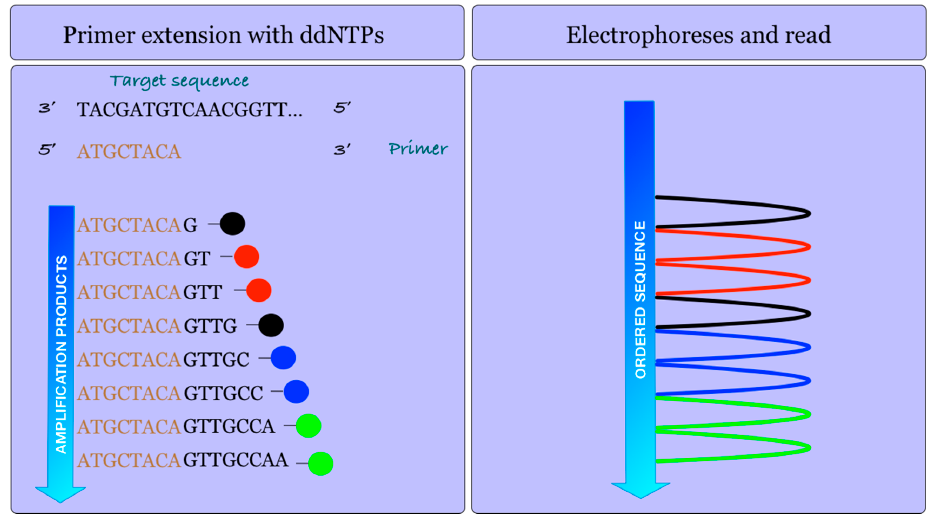
Figure 5. The sanger dideoxy sequencing method or chain termination enzymatic method. The sanger dideoxy sequencing method or chain termination enzymatic method. Fluorescence-labeled ddNTPs block DNA amplification. Fluorescence-labeled ddNTPs block DNA amplification.